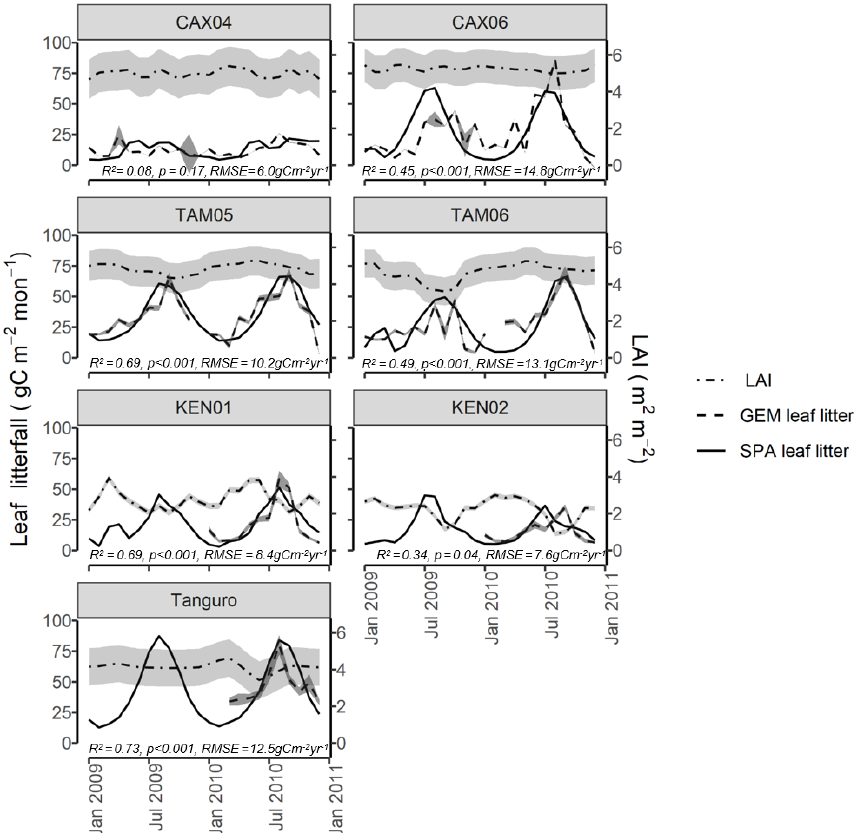
Figure 4. Field estimated monthly LAI, leaf litterfall (GEM) and standard error, compared with SPA-simulated leaf litterfall for seven plots at four locations across the Amazon basin. SPA leaf litterfall was calibrated against GEM estimates to derive three fixed model drivers relating to the leaf cycle (peak leaf fall timing, leaf fall period and leaf lifespan). GEM leaf litterfall data were available for 2009–2010 for CAX04, CAX06, TAM05 and TAM06 and for 2010 only for KEN01, KEN02 and Tanguro. R 2 , p value and RMSE estimates presented are derived from linear regressions between monthly GEM measurements and SPA simulations.